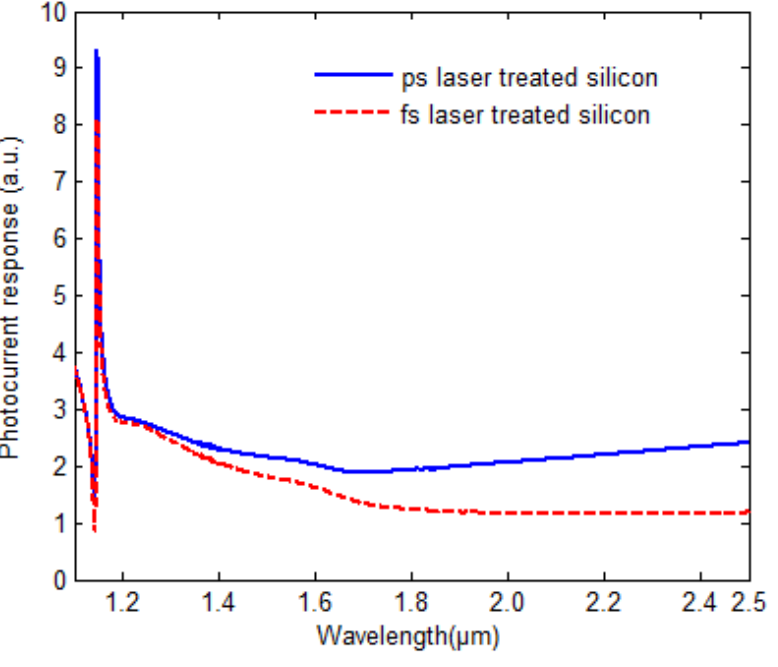
Figure 7. The photocurrent response at near ‐ infrared wavelength for fs ‐ laser ‐ treated silicon and ps ‐ laser ‐ treated silicon.